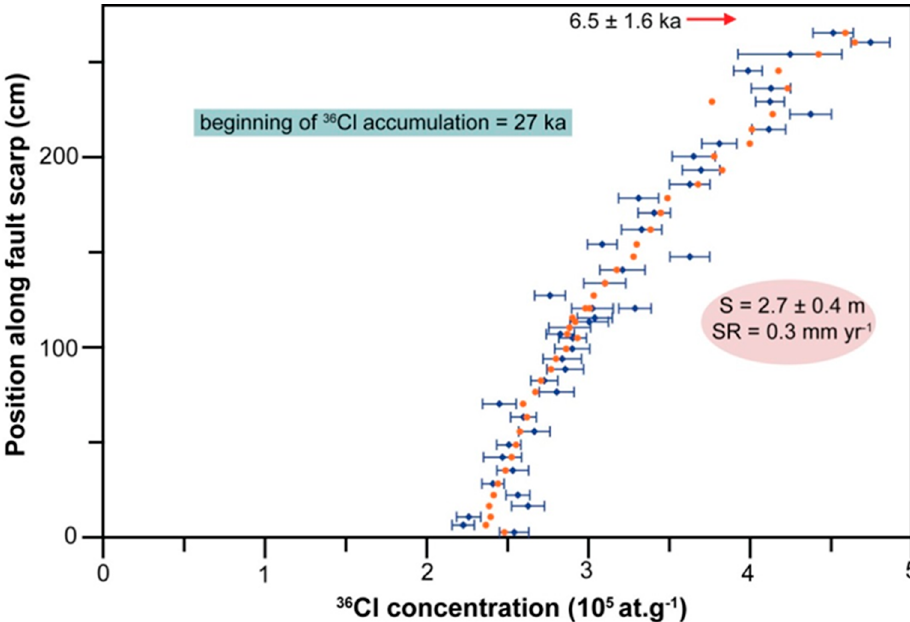
Figure 9. Best fit (filled circles) of the data for the samples from the Mugırtepe fault scarp with a single seismic event model and beginning of 36 Cl accumulation ca. 27 ka. Dots with 2 σ uncertainties are measured 36 Cl concentrations. The arrow marks the colluvium positions before the modeled seismic event. S and SR define the amount of slip and incremental slip rate, respectively.